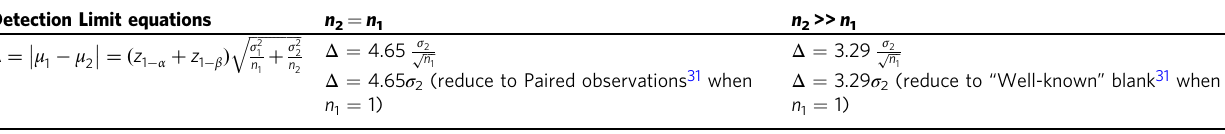
Table 4 The mathematical reduction of Detection Limit equations to Currie formulars 31 under certain assumptions. Detection Limit equations